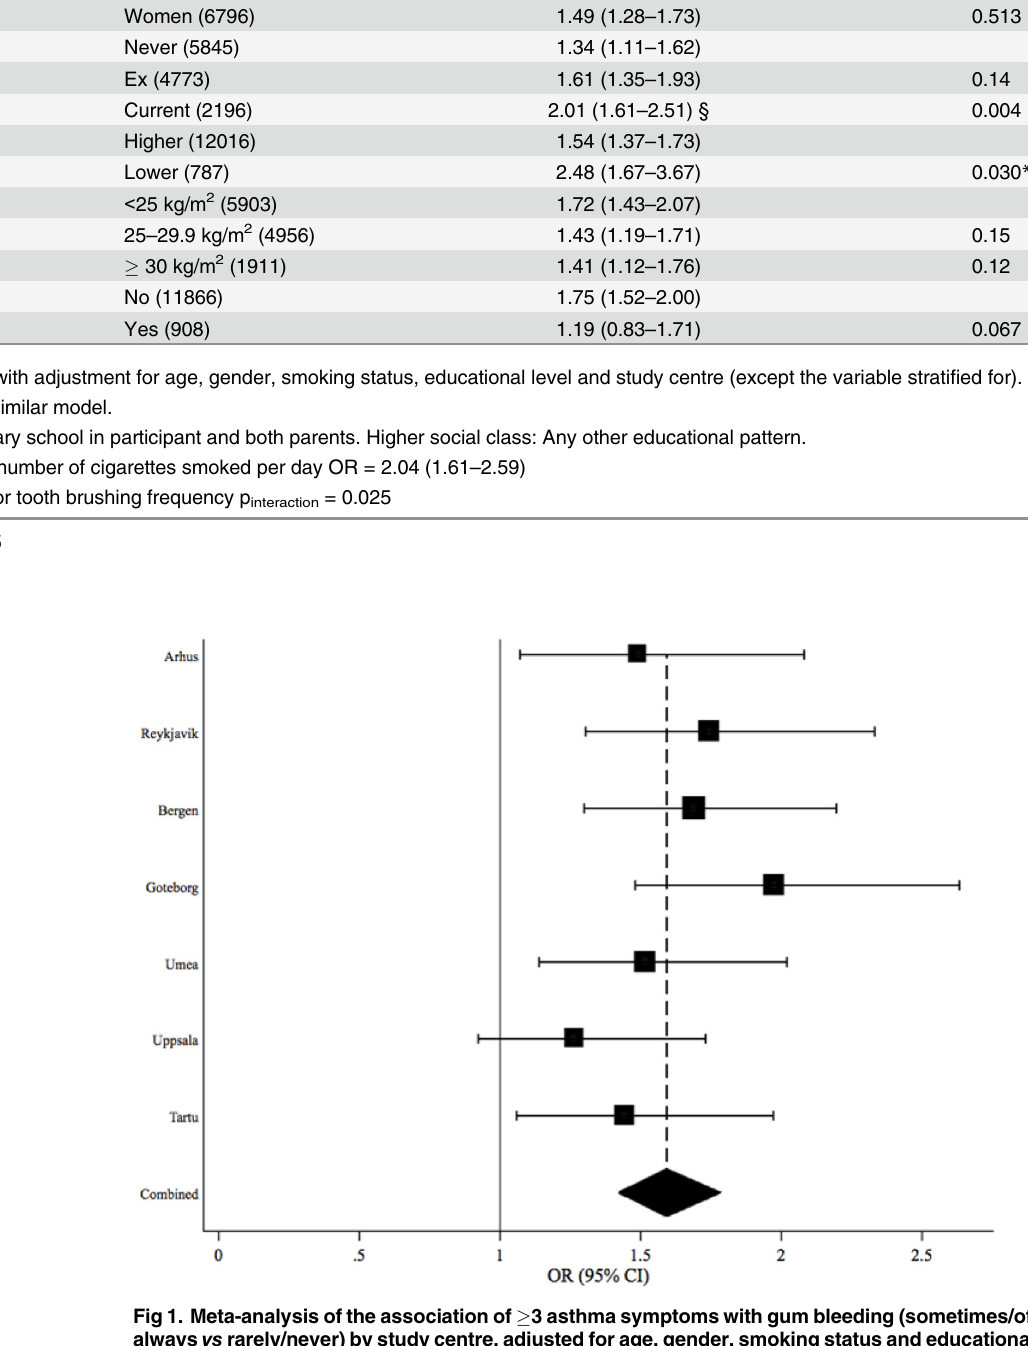
Table 5. The association of gum bleeding (sometimes /often / always vs never/ rarely) with (cid:1) 3 asthma symptoms, in strata according to gender, smoking status, social class, body mass index and asthma medication. Variable